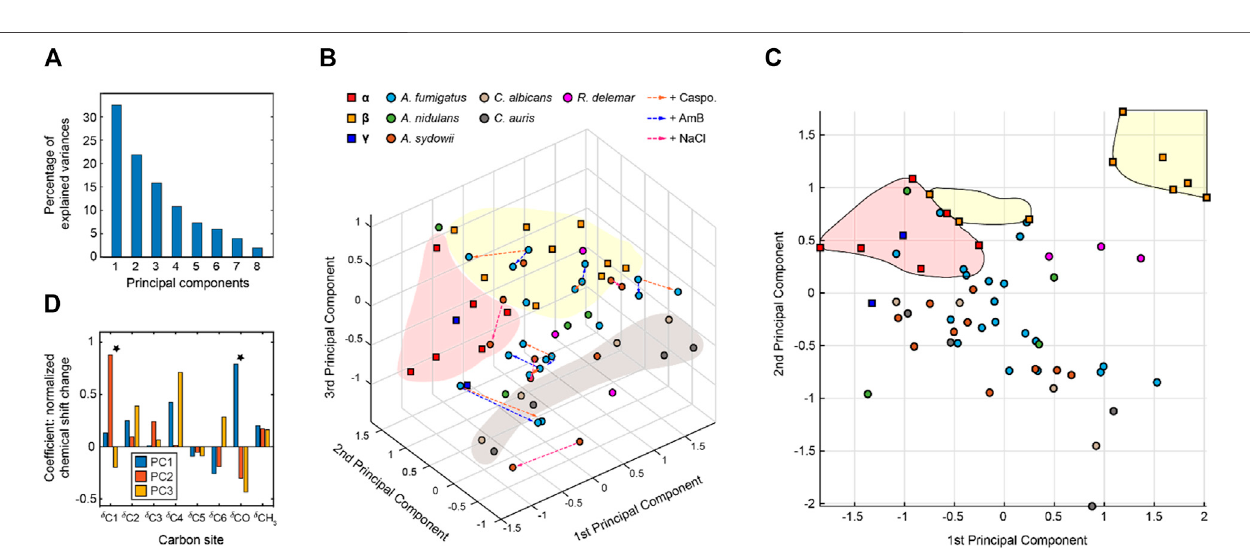
FIGURE 4 | Principal component analysis of chitin chemical shifts. (A) Variance explained by each principal component (PC). (B) PCA scores for chitin NMR chemical shifts projected onto principal component 1 (PC1) vs. PC2 vs. PC3. Model chitin allomorphs ( α , β , and γ -types) are shown using squares while chitin forms identi fi ed in fungal cell walls are presented using circles. Shaded regions in red and yellow are used to enclose α - and β -type chitins, respectively. The shaded region in grey mainly contains data from Candida species. Data from different model samples and fungal species are color-coded. Arrows in orange, blue, and magenta representsthechangesinducedbycaspofungin (Caspo.),theamphotericinB(AmB),andNaCl(from0.5to2.0 M),respectively. (C) PCAscoresofchitinchemicalshifts projected onto PC1 and PC2 proving a better visualization of most chitin forms. (D) Loadings for each PC. Asterisks indicate the most pronounced differences for PC1 and